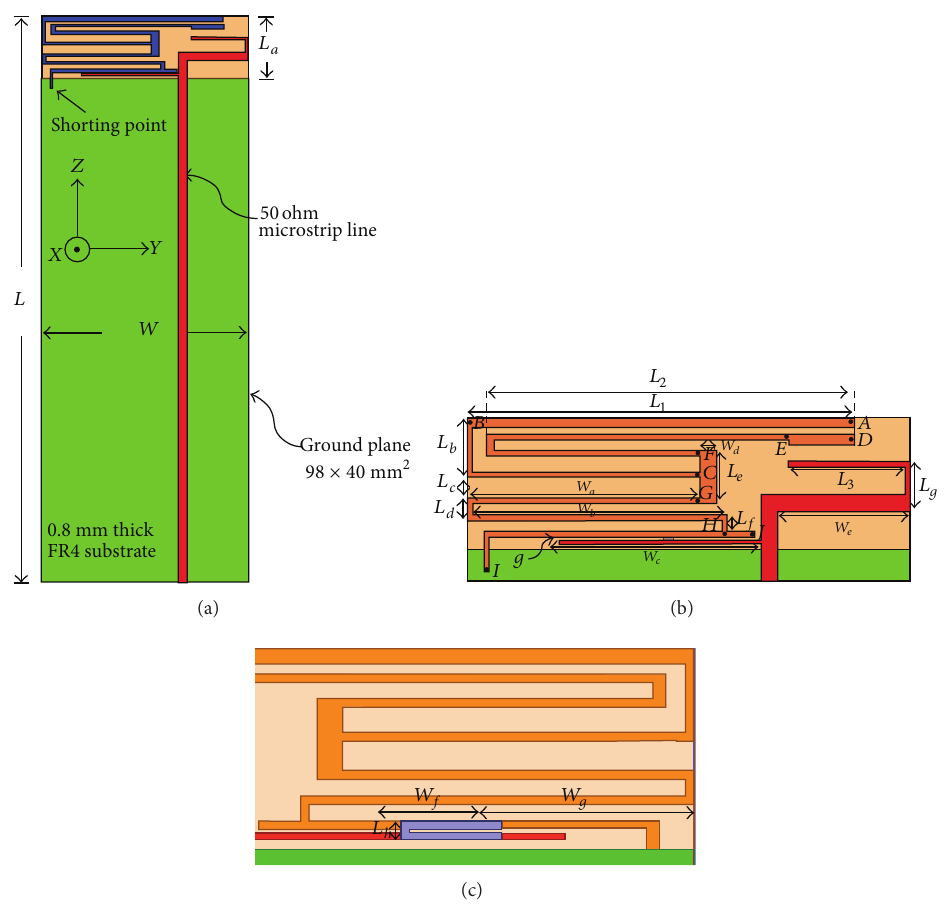
Figure 1: The geometry of the proposed compact printed antenna (a) with system ground, (b) top view, and (c) bottom view.